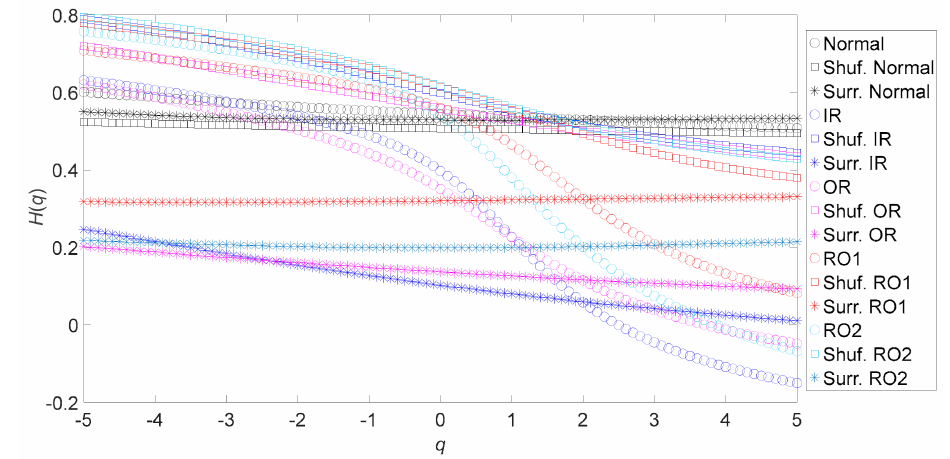
Figure 25. Generalized Hurst exponents of the original, shuffle, and surrogate versions of the five types of roller-bearing vibration data. Here, the abbreviations shuf. and surr. indicate shuffle and surrogate,